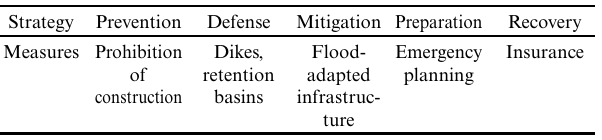
Table 1 . Flood risk strategies (cf. Hegger et al.